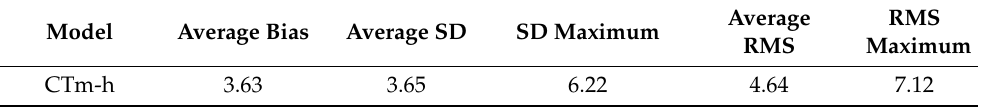
Table 3. Precision statistics of CTm-h model of radiosonde station